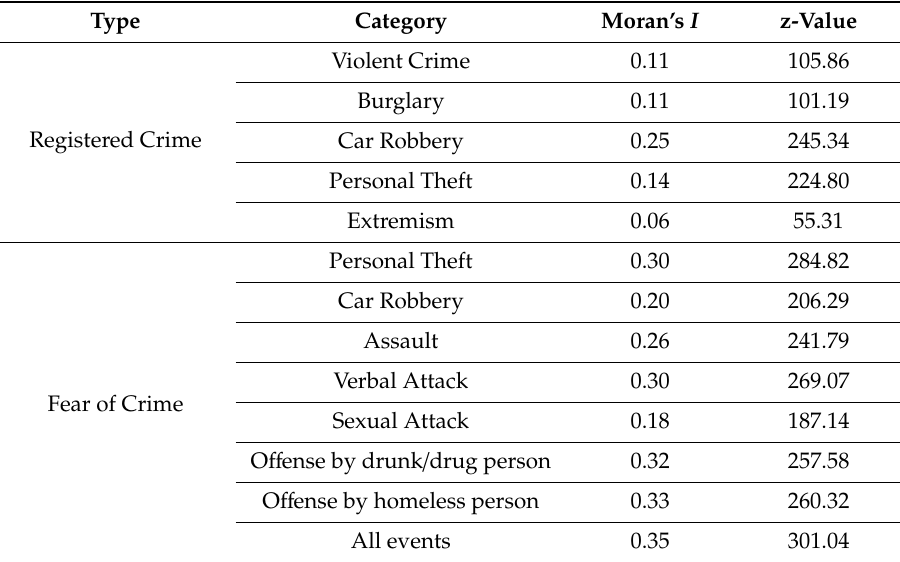
Table 2. Moran’s I of recorded crime data and the fear of crime